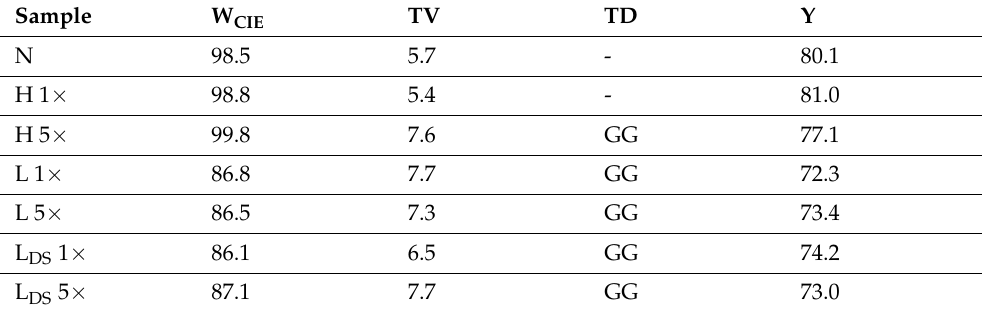
Table 3. Average whiteness of the back of medical masks before and after washing.